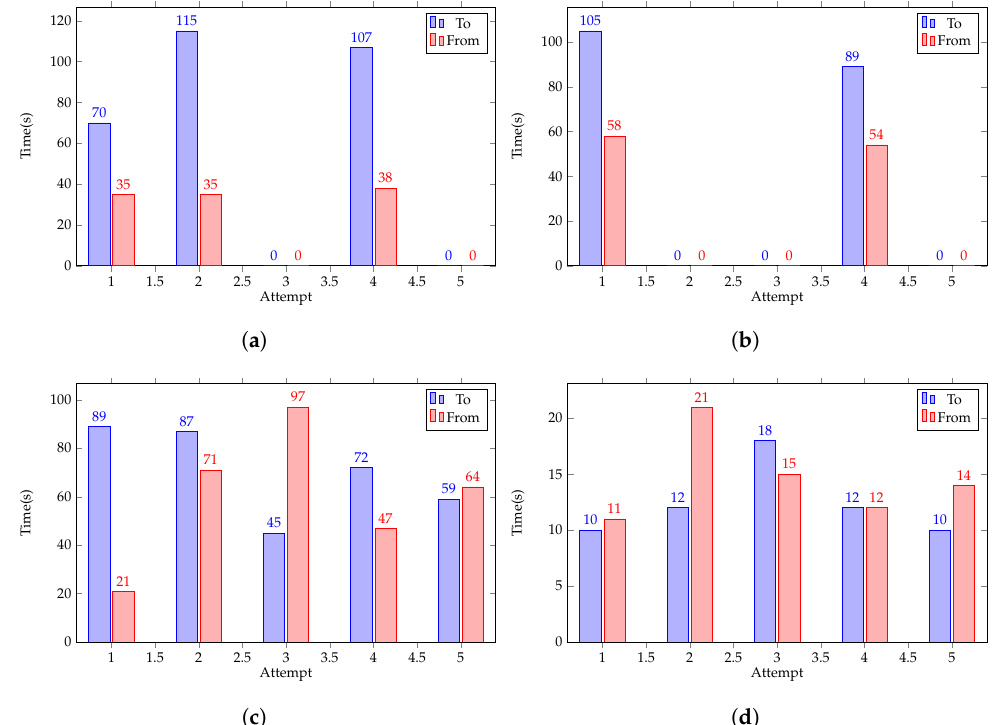
Figure 13. ( a ) Default test bench results. ( b ) Test bench results with only forward speed increase. ( c ) Test bench results with both forward speed and update frequency increase. ( d ) Final tune test bench